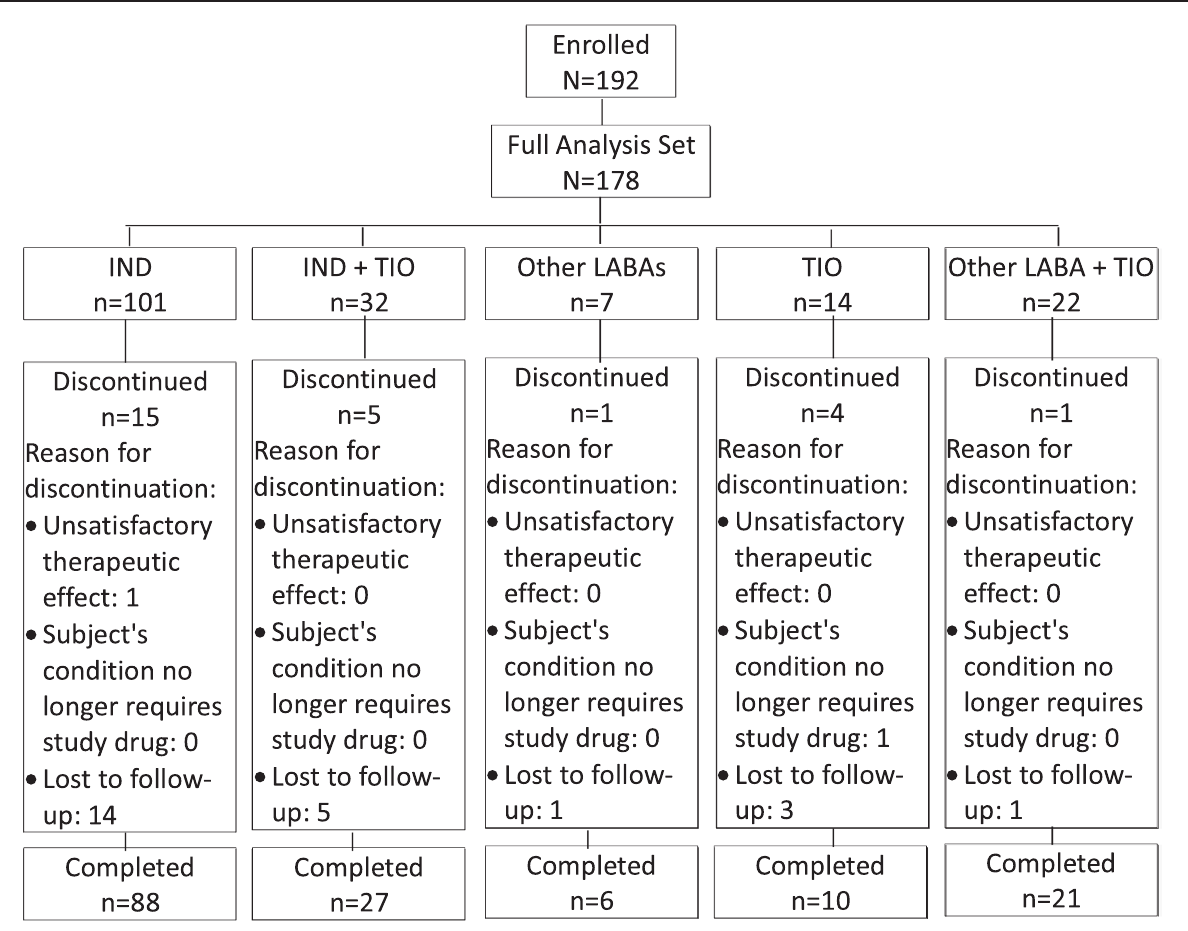
Patient disposition. IND, indacaterol; TIO, tiotropium; n , number of patients in each group; N , total number of